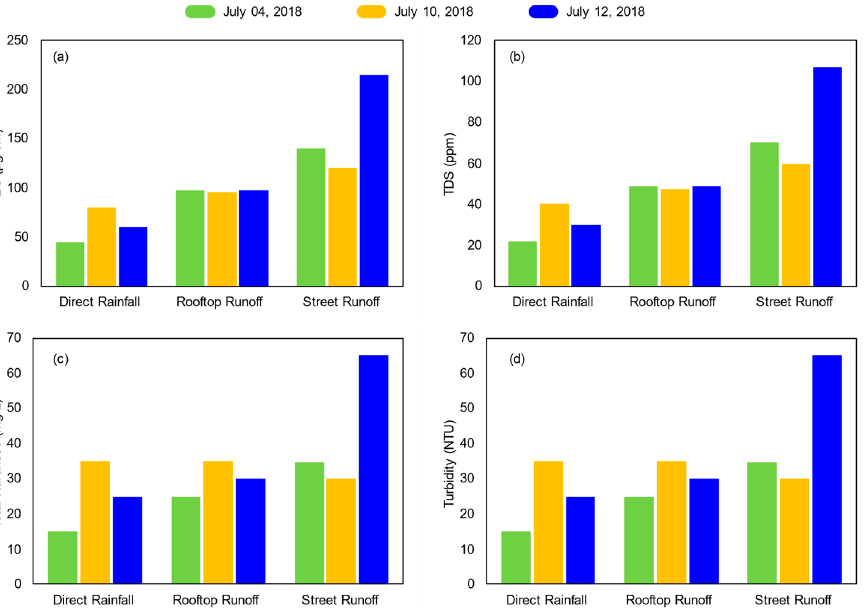
Figure 7. Inter-day profile of ( a ) electrical conductivity ( µ g/cm), ( b ) total dissolved solids (ppm), ( c ) total hardness (mg/L), and ( d ) turbidity (NTU) at Site S2—Experimental Research Station, Niazbeg, Lahore, Pakistan.